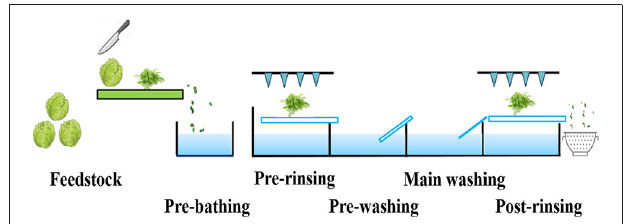
FIGURE 1 | An example process line, the illustrated washing process of a tap water reference (process variant Ia): five washing sections—pre-bathing, pre-rinsing, pre-washing, main washing, and post-rinsing.